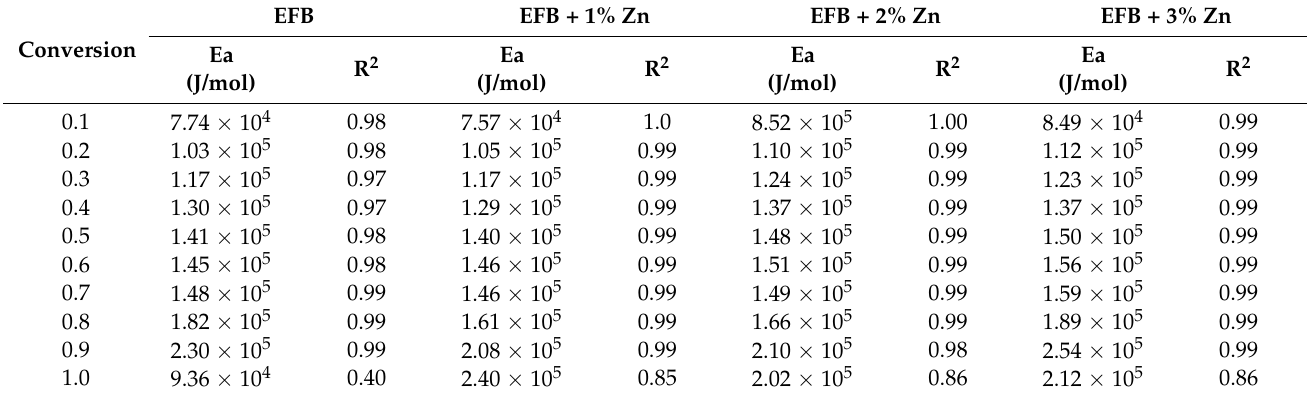
Table 5. Kinetic results pre-exponential factor model.